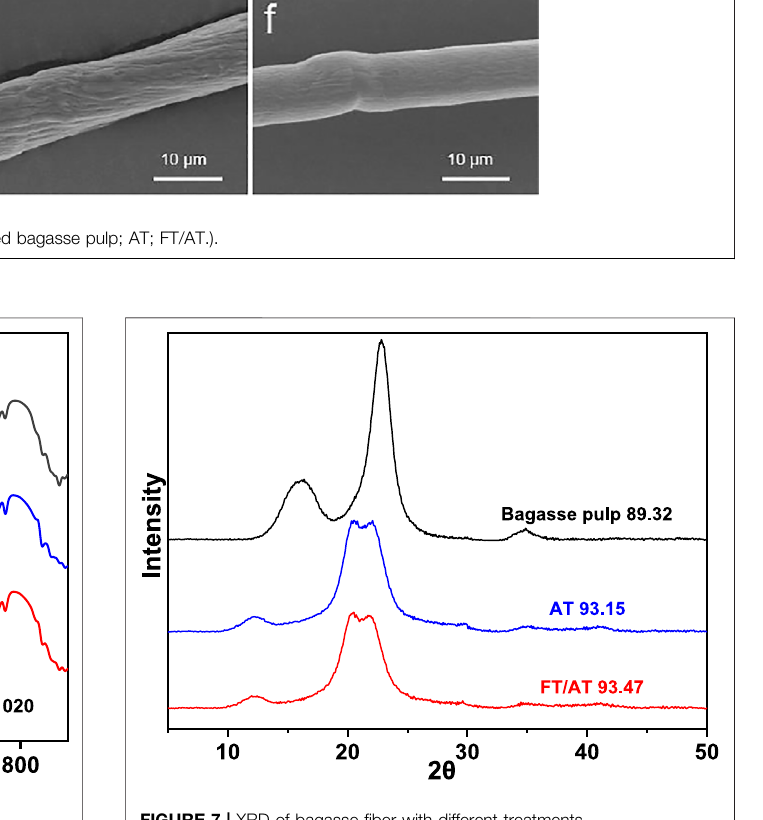
FIGURE 6 | FTIR of bagasse fi ber with different treatments.